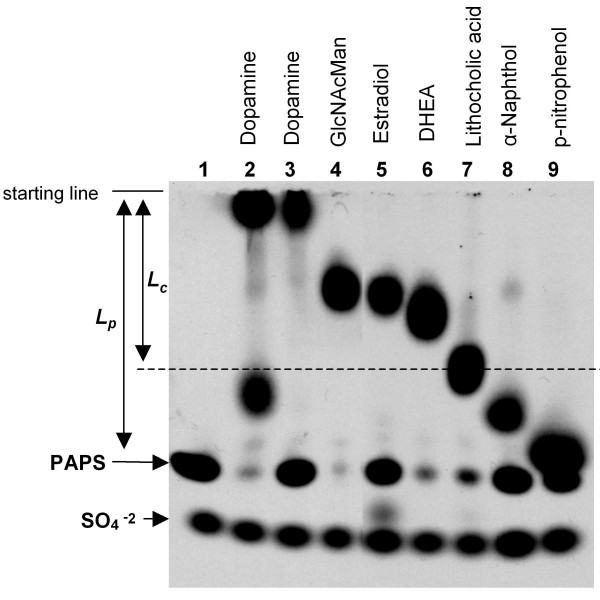
Relative mobility of various sulfated small molecule products. To maximize the sensitivity of the detection, no cold PAPS was added into these reactions. Acceptor substrates are indicated on top of the autoradiogram. Lane 1 contained no acceptor substrate but 1 μg of rhSULT1A1. Lane 2, 3, 4 were labeled with 1 μg of rhSULT1A1, rhSULT1E1 and rhCHST4 respectively. All other lanes were labeled with 1 μg rhSULT2A1. Two product bands were observed in rhSULT1A1/dopamine reaction (lane 2) but not in rhSULT1E1/dopamine reaction (lane 3). Acceptor substrate inputs from lane 2 to 9 respectively were: 100 nmol dopamine, 100 nmol dopamine, 20 nmol GlcNAcMan, 10 nmol estradiol, 1 nmol DHEA, 10 nmol lithocholic acid, 10 nmol α-naphthol, and 100 nmol p-nitrophenol. The broken line indicates the position of the sulfated lithocholic acid. The distances that sulfated lithocholic acid and PAPS traveled are indicated as Lc and Lp, respectively. The ratio of Lc and Lp, 0.63, is the observed relative mobility for mono-sulfated lithocholic acid.